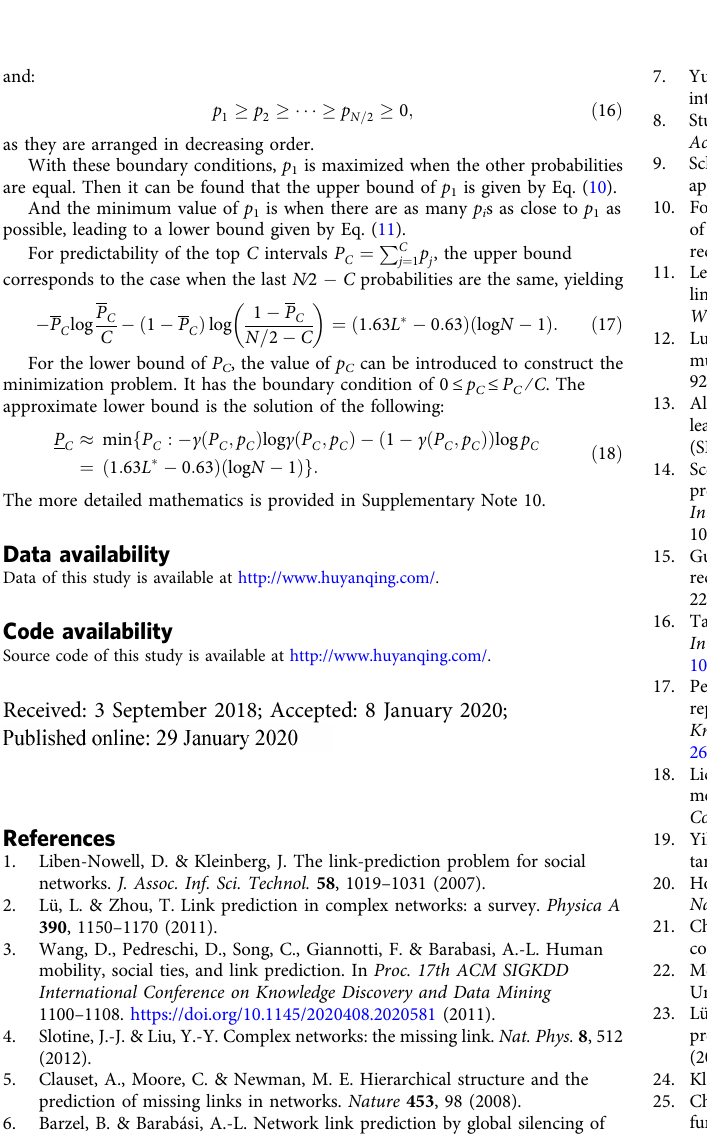
) as k c decreases. It is BPAA